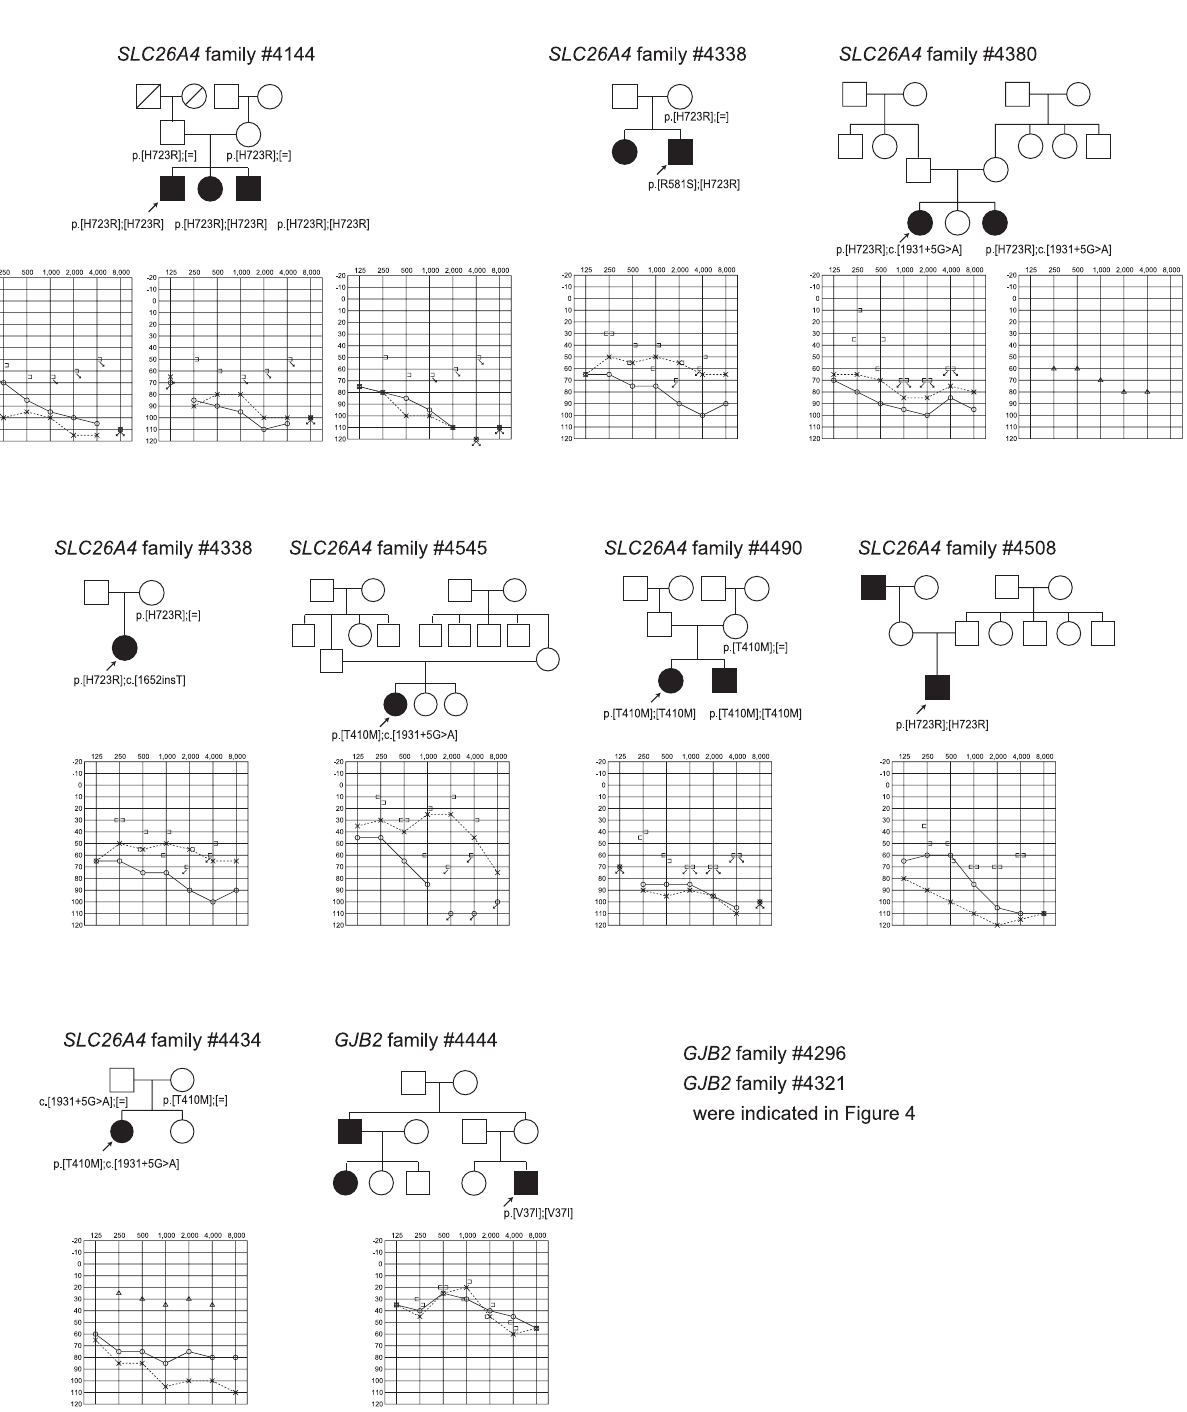
Figure 6. Examples of the families and audiograms of the patients with missense mutations after confirmation by Sanger sequencing.